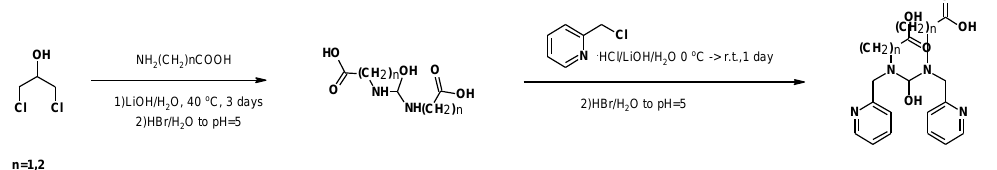
Figure 11. Synthesis of the H 3 hpnbpda ligand.